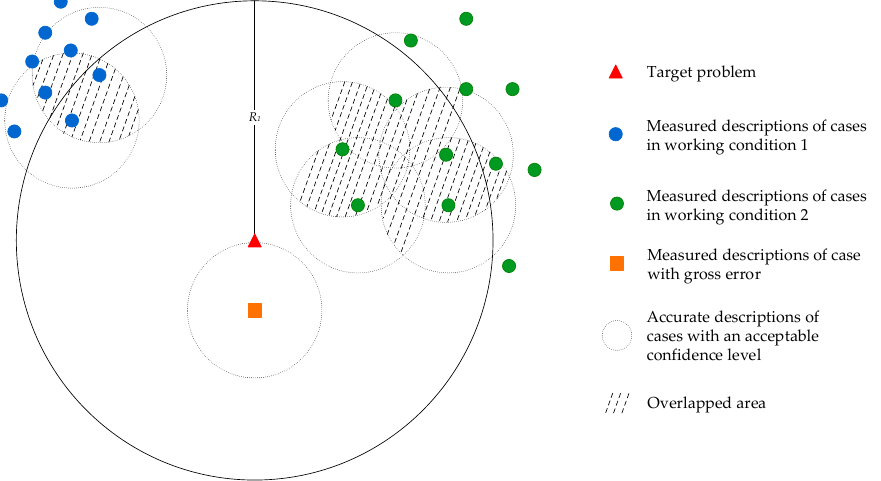
Figure 2. Distribution and reliability of the retrieved cases in industrial processes.